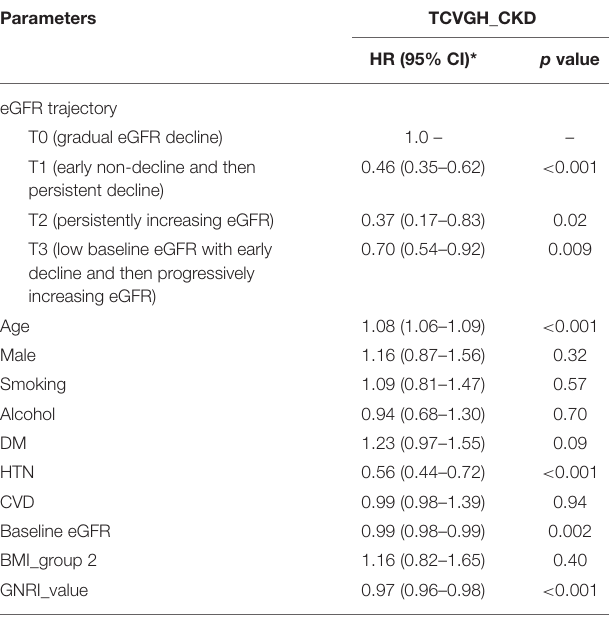
TABLE 4 | Effects of kidney function trajectories and comorbid illnesses on all-cause mortality among 3,948 older patients with chronic kidney disease without multiple imputation for missing data and without selection for